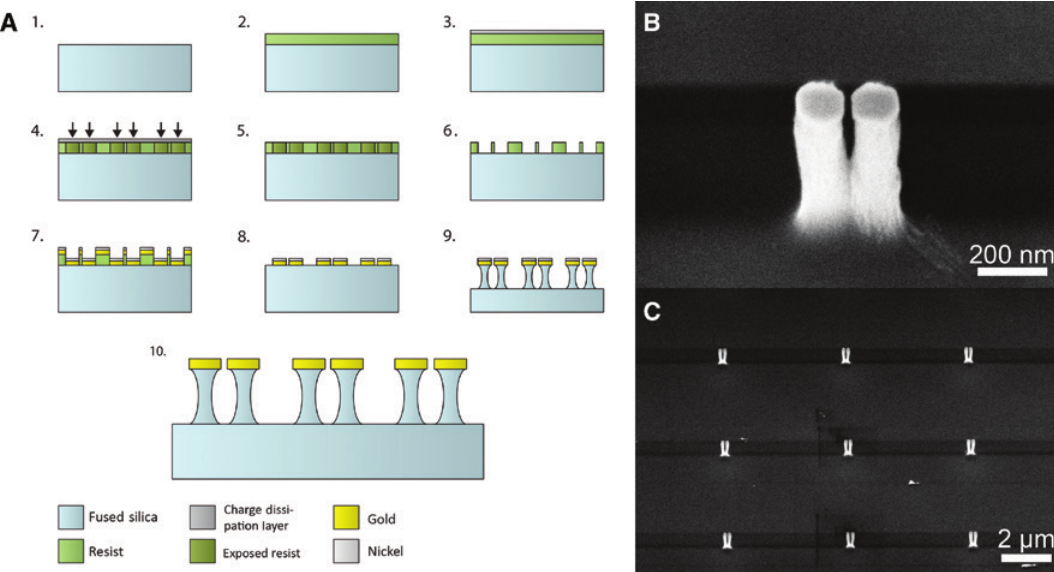
Figure 1: Fabrication of nanopillar dimer arrays. (A) Schematic of the individual process steps to fabricate nanopillar dimer arrays, involving electron-beam lithography to define nanodisk dimers and reactive-ion etching of the substrate to form nanopillars. (B) Scanning electron micrograph of a single 150 nm diameter 400 nm tall nanopillar dimer with a gap of 15 nm. (c) Array of 5 μm separated nanopillar dimers with a pillar height of 740